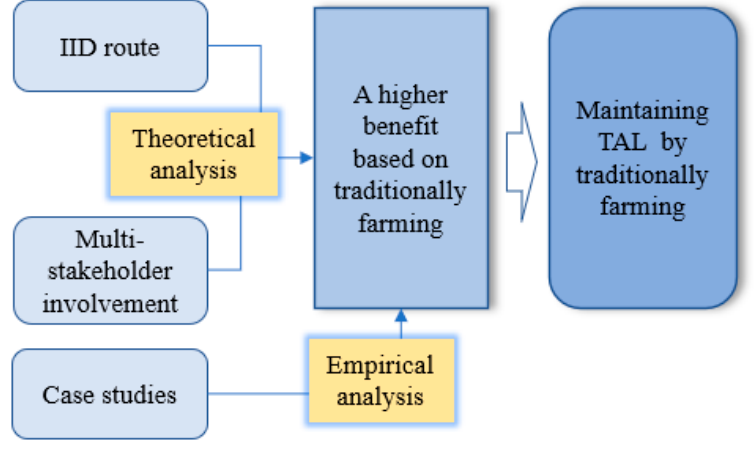
Figure 1. Logic framework of this